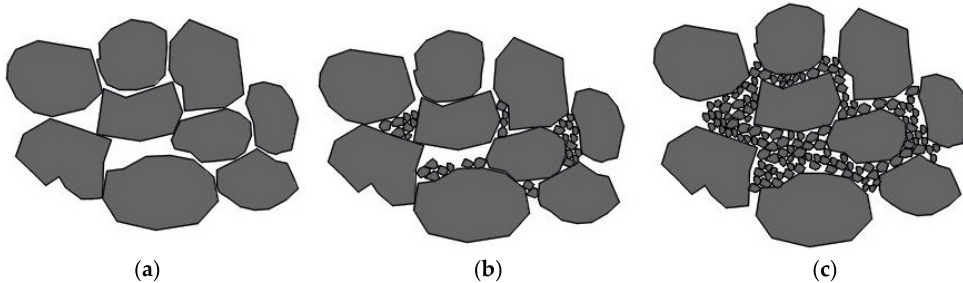
Figure 3. Ballast fouling stages: ( a ) clean ballast contact point; ( b ) minor fouling, contact point unaffected; ( c ) contact point contaminated, causing instability [19].